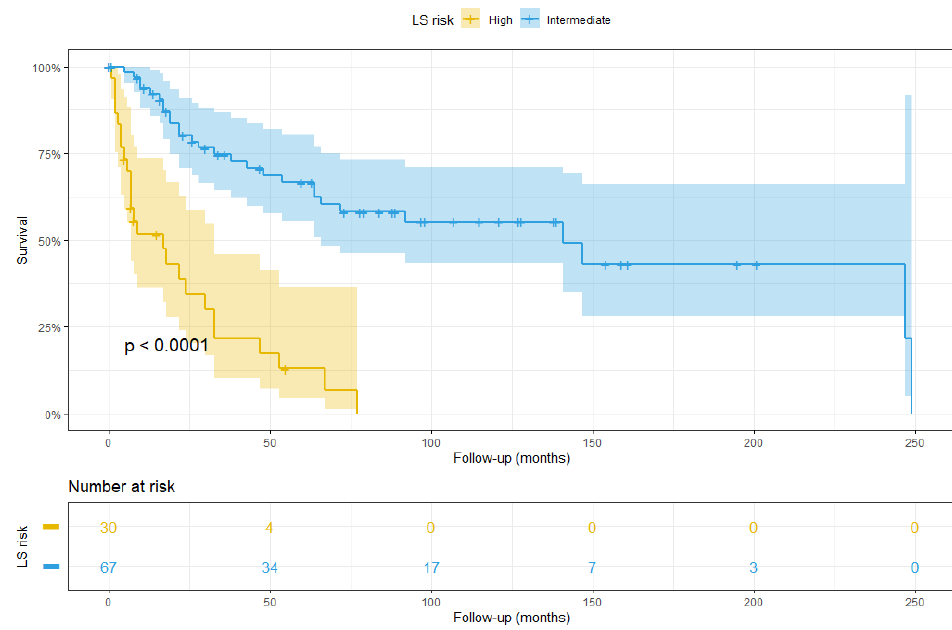
Figure 7. Kaplan–Meier plot showing patient at high (yellow) and intermediate (blue) risk according to ISUP